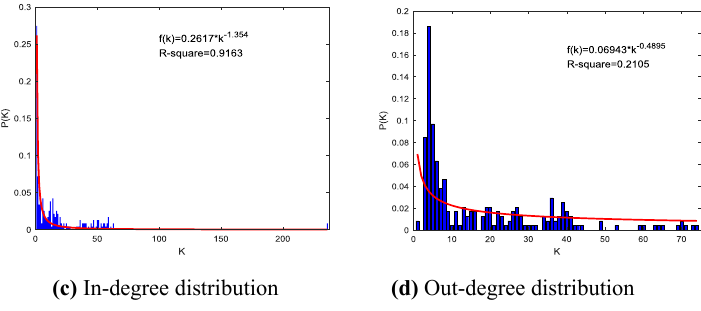
Fig. 5. Degree distribution for network II.